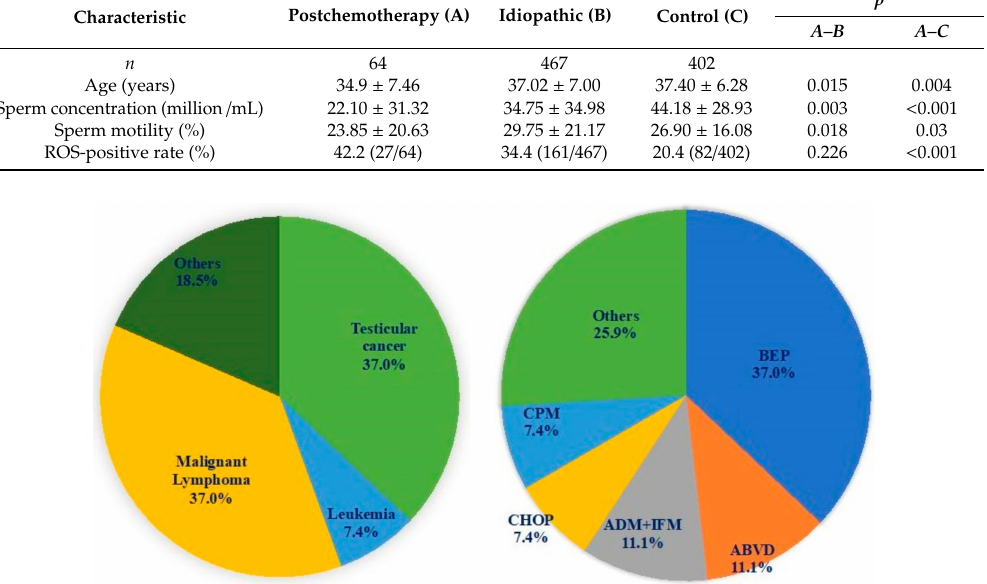
Figure 2. Breakdown of original diseases and chemotherapeutic regimens of those positive for ROS. Testicular cancer and malignant lymphoma were equally frequent. As for the therapeutic regimen, BEP was the most frequent. BEP: Bleomycin, etoposide, and cisplatin, ABVD: Doxorubicin, bleomycin, vinblastine, and dacarbazine, ADM: Doxorubicin, IFM: Ifosfamide, CHOP: Cyclophosphamide, doxorubicin, vincristine, and prednisone, CPM: Cyclophosphamide.